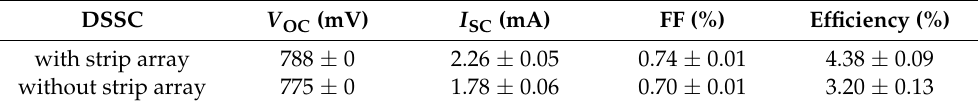
Table 1. Averaged photovoltaic parameters of DSSCs with and without the TiO 2 strip array.